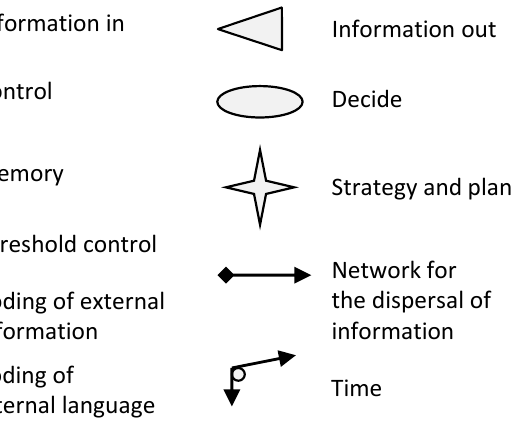
Figure 2. Infostructure